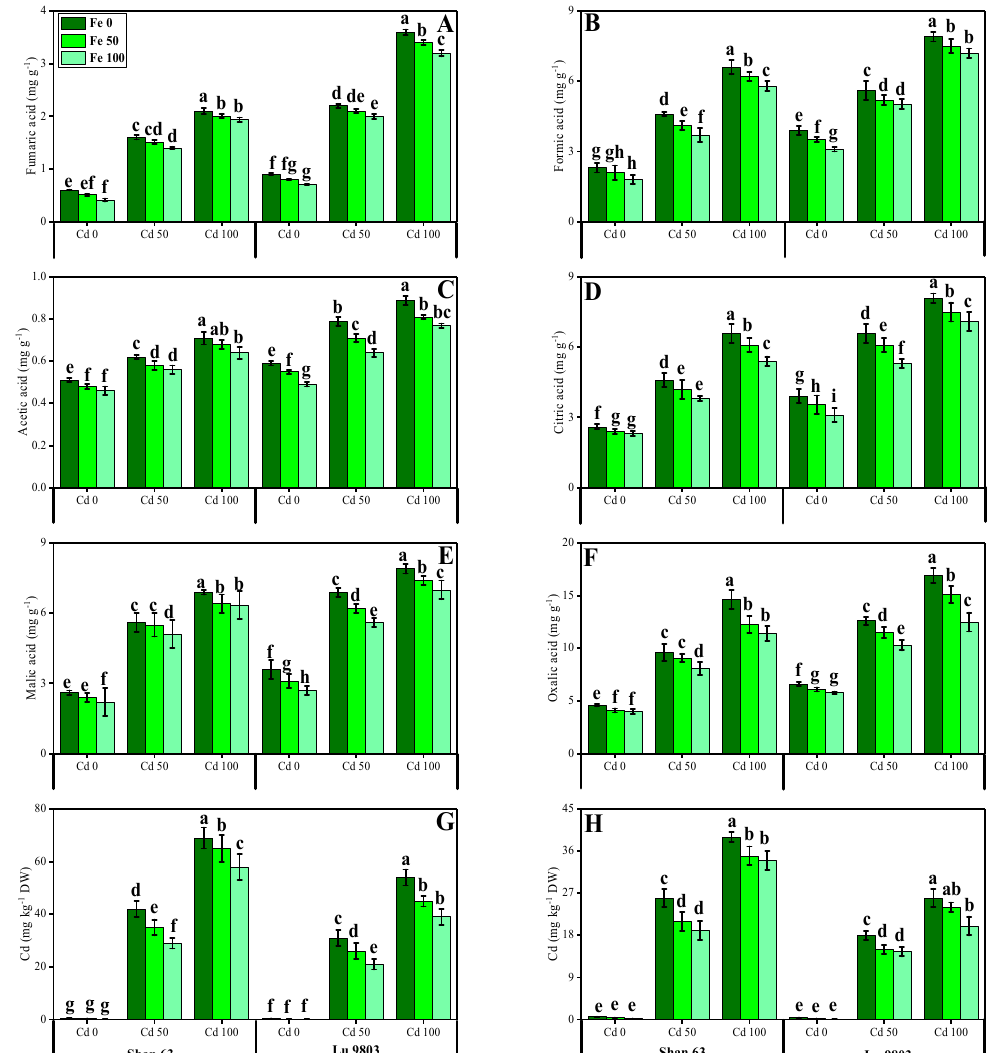
Figure 7. Effect of different concentrations of exogenous application of FeSO 4 (0, 50, and 100 µM) on fumaric acid contents ( A ), formic acid contents ( B ), acetic acid contents ( C ), citric acid contents ( D ), malic acid contents ( E ), oxalic acid contents ( F ) in the roots and Cd concentration in the roots ( G ) and Cd concentration in the shoots ( H ) of Oryza sativa (cultivars) grown under different levels of Cd stress (0, 50 and 100 µM). Bars sharing different letter(s) for each parameter are significantly different from each other according to Duncan’s multiple range test ( p < 0.05). All the data represented are the average of four replications ( n = 4). Error bars represent the standard deviation (SD) of four replicates.